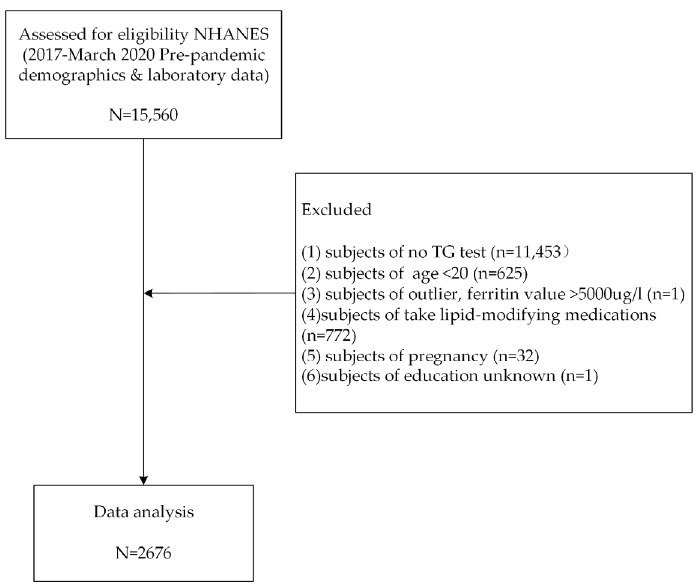
Figure 1. Flowchart showing the selection of participants in the study.